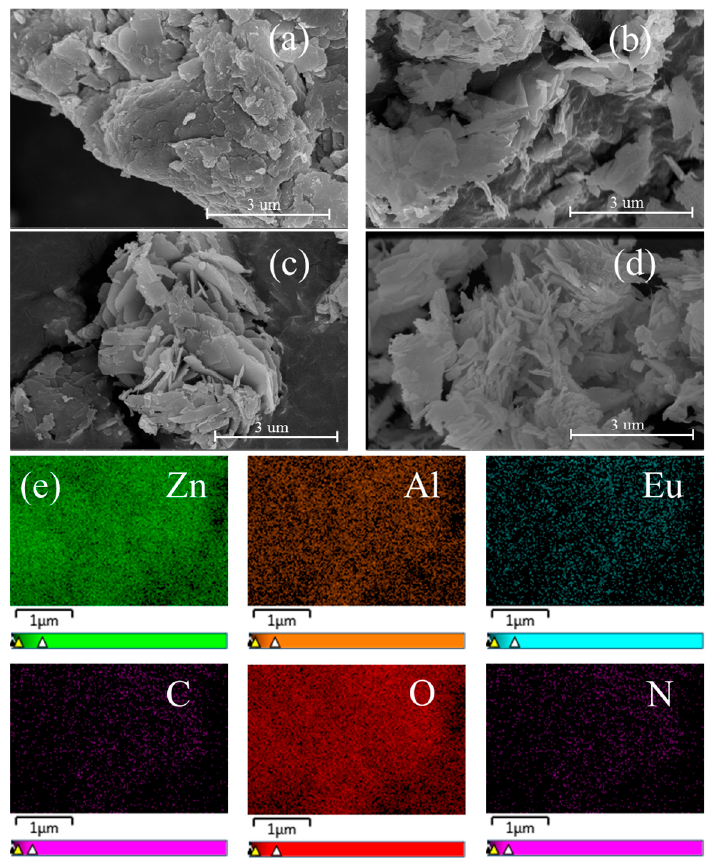
Figure 3. SEM images of ( a ) L1, ( b ) L2, ( c ) L2-La, ( d ) L2-Eu and ( e ) mapping image of L2-Eu.